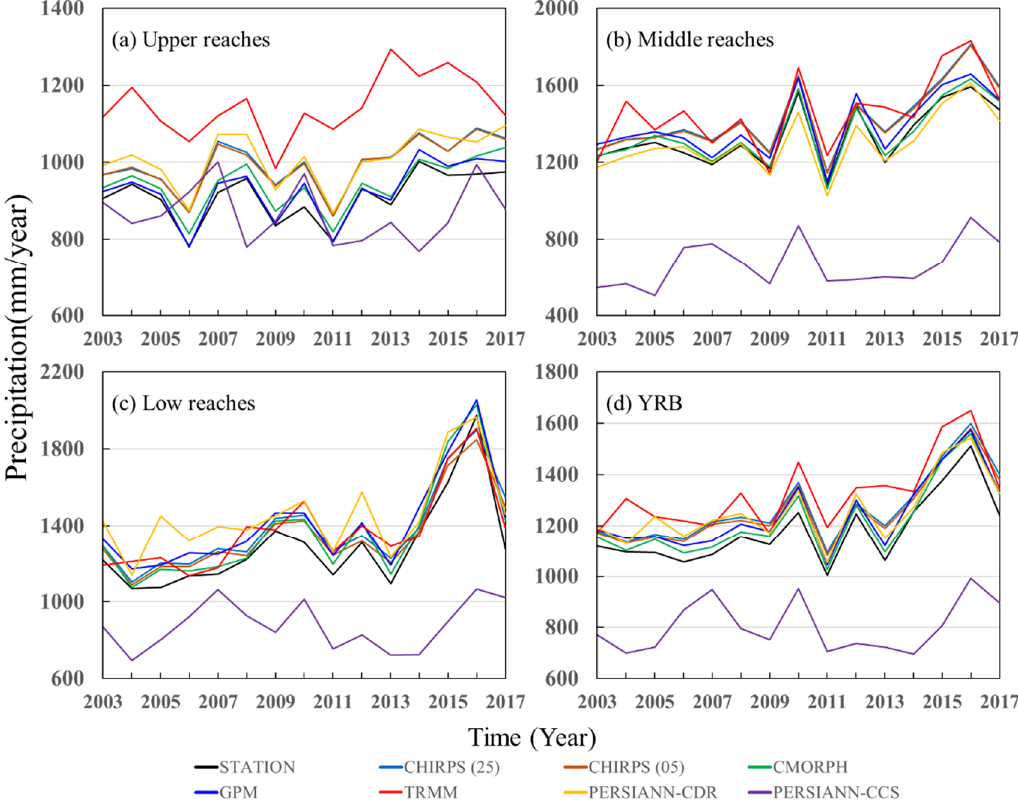
Figure 2. Annual average precipitation derived from stations and SPPs for 2003–2017. Table 5. Bias of SPP annual average precipitation relative to station (unit: %). Upper Reaches Middle Reaches Lower Reaches